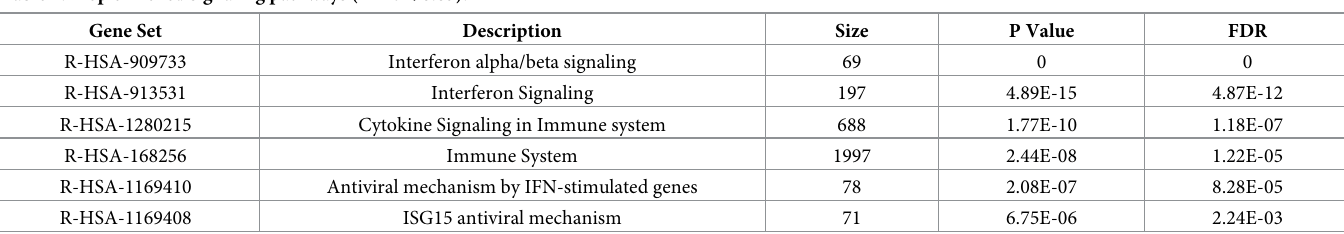
Table 2. Top enriched signaling pathways (FDR <